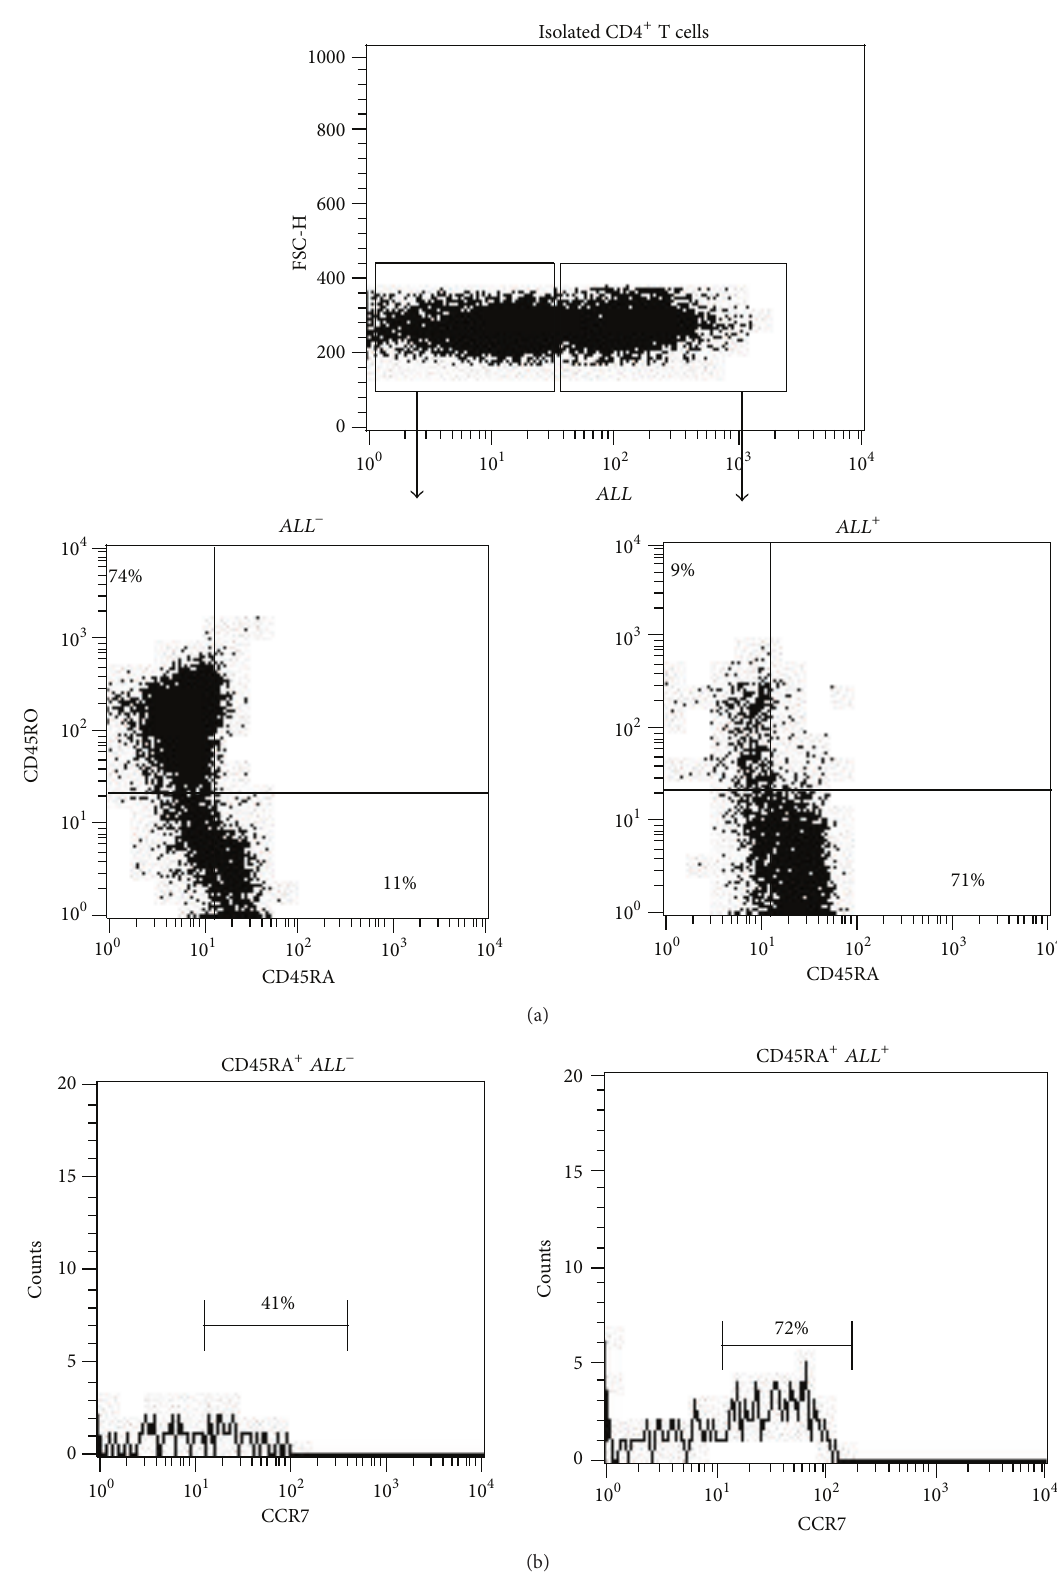
Figure 2: ALL recognition of CD4 + T cells with phenotype positive to CD45RA and CCR7 markers. (a) Dot plots of ALL − and ALL + gated cells showing frequency of CD45RO + and CD45RA + cells. (b) Representative histograms of CD45RA + gated cells to analyze CCR7 frequency in both ALL − and ALL + T helper cells. The numbers denote percentage of cells positive to the